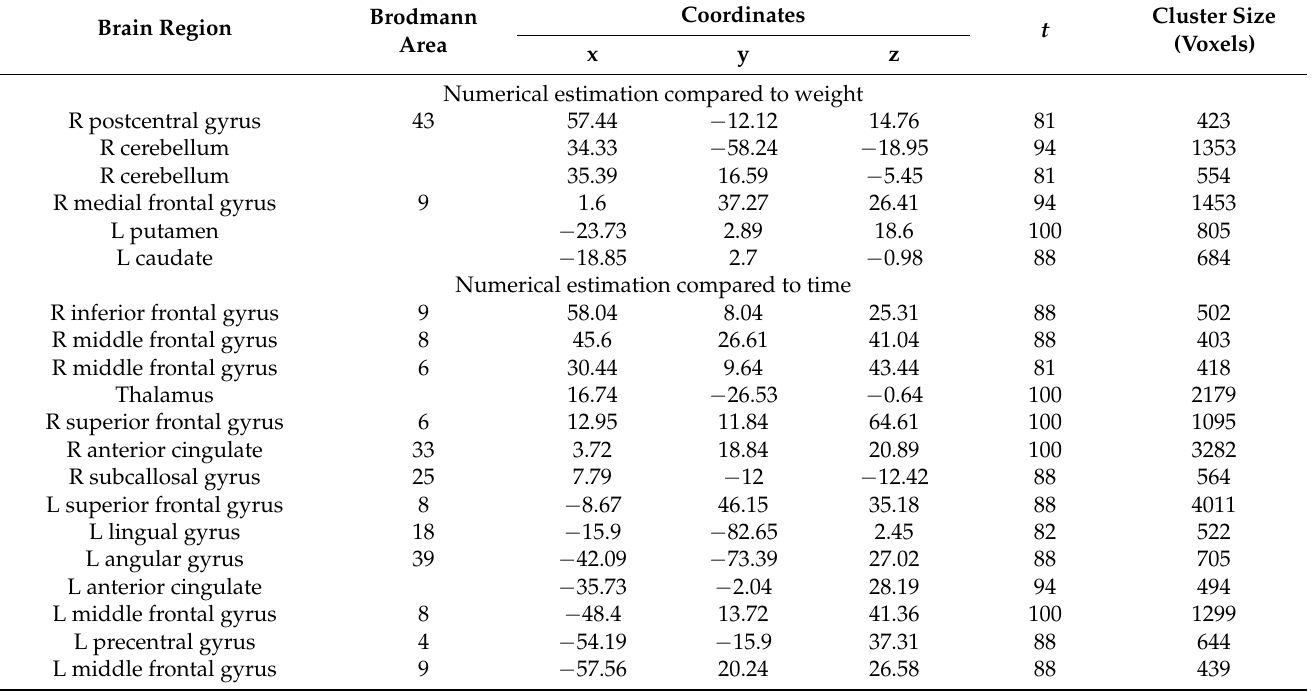
Table 2. Brain Region by Contrast, Multi-Voxel Pattern